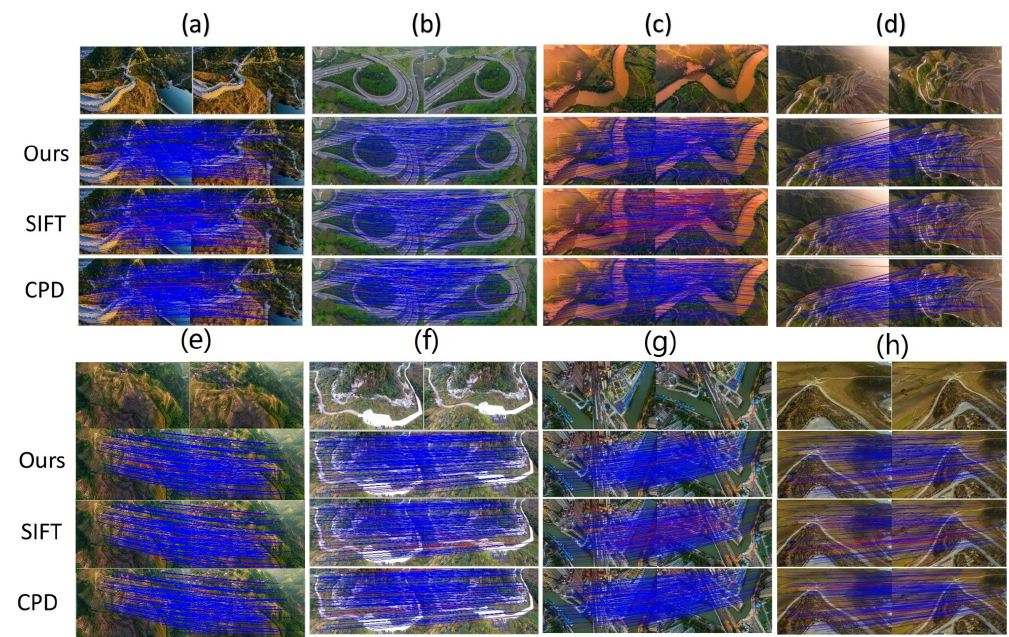
Figure 9. Feature matching demonstrations on eight typical image pairs of dataset (i) and (ii). For each image pair, rows from the first to the fourth are: the image pair, the results on feature matching of ours, SIFT and CPD, respectively. Blue lines indicate true positive and true negative, red lines indicate false positive and false negative. The PRs of three methods on each image pairs are listed from ( a ) to ( h ) as follows. Ours: 99.00 , 99.29 , 97.31 , 97.40 , 99.32 , 99.62 , 98.31 , 98.89 ; SIFT: 85.68, 85.18, 45.12, 60.26, 82.43, 80.34, 82.43, 83.55; CPD: 86.86, 88.14, 85.02, 88.24, 87.22, 85.55, 89.76,